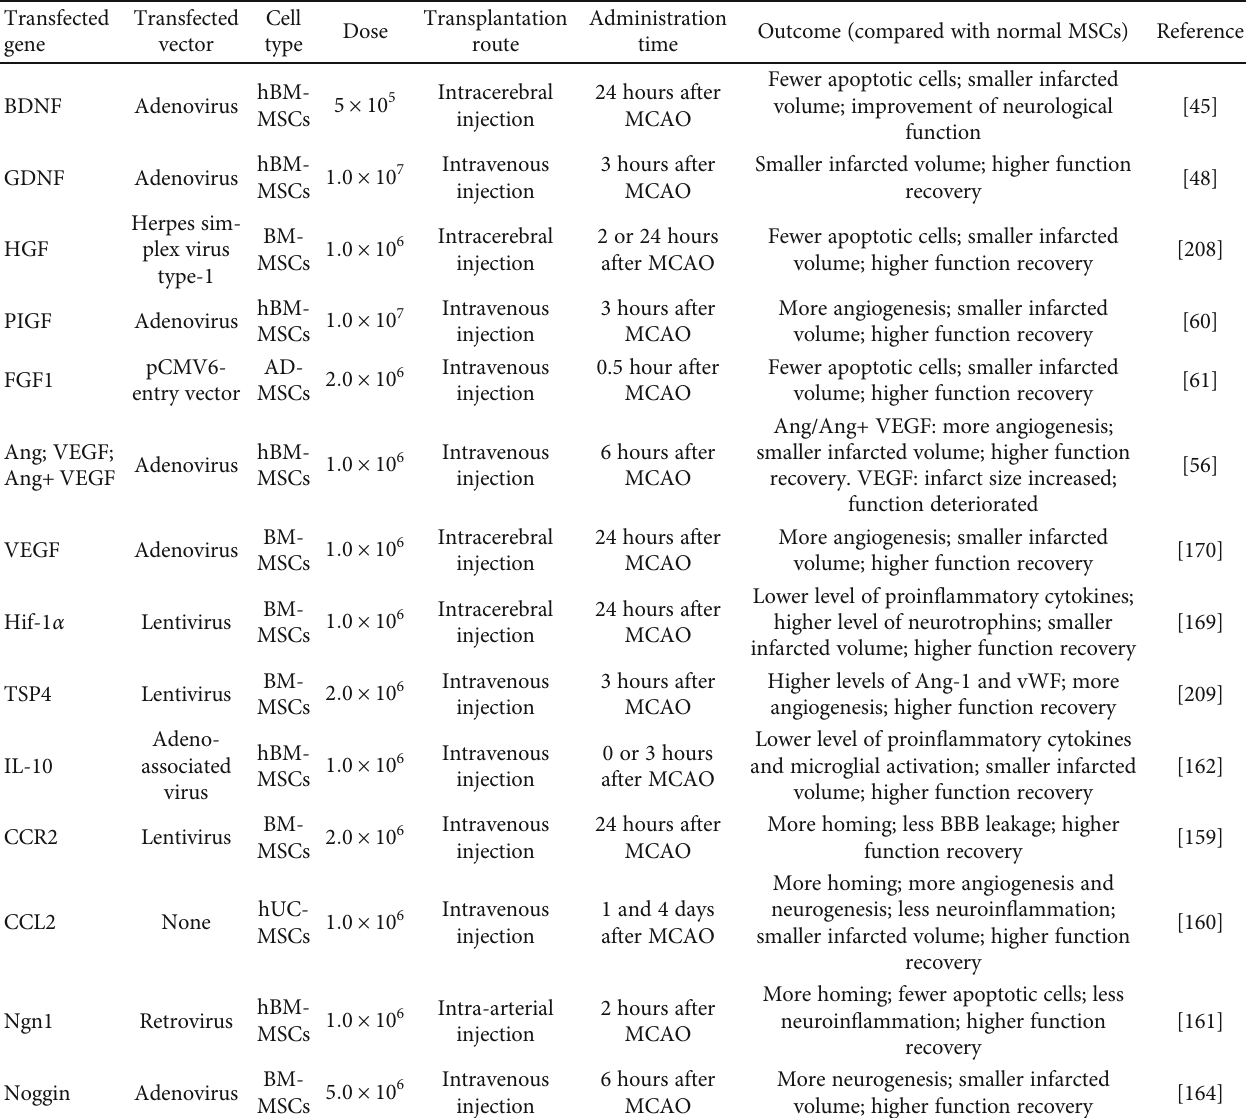
Table 2: Gene transfection in the treatment of IS with